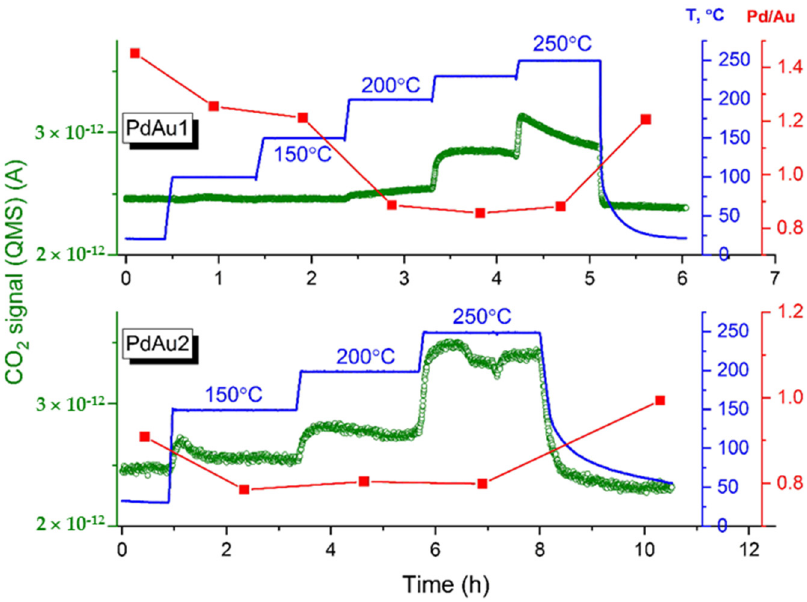
Figure 2. The mass-spectrometric signal of CO 2 (corresponding to m / z = 44) (shown as green open circles) and Pd/Au atomic ratios (shown as red squares connected with a line) calculated from Pd3d and Au4f X-ray photoelectron spectra measured for PdAu-1 ( upper panel ) and PdAu-2 ( bottom panel ) samples in the CO + O 2 reaction mixture as a function of temperature (shown as blue lines).